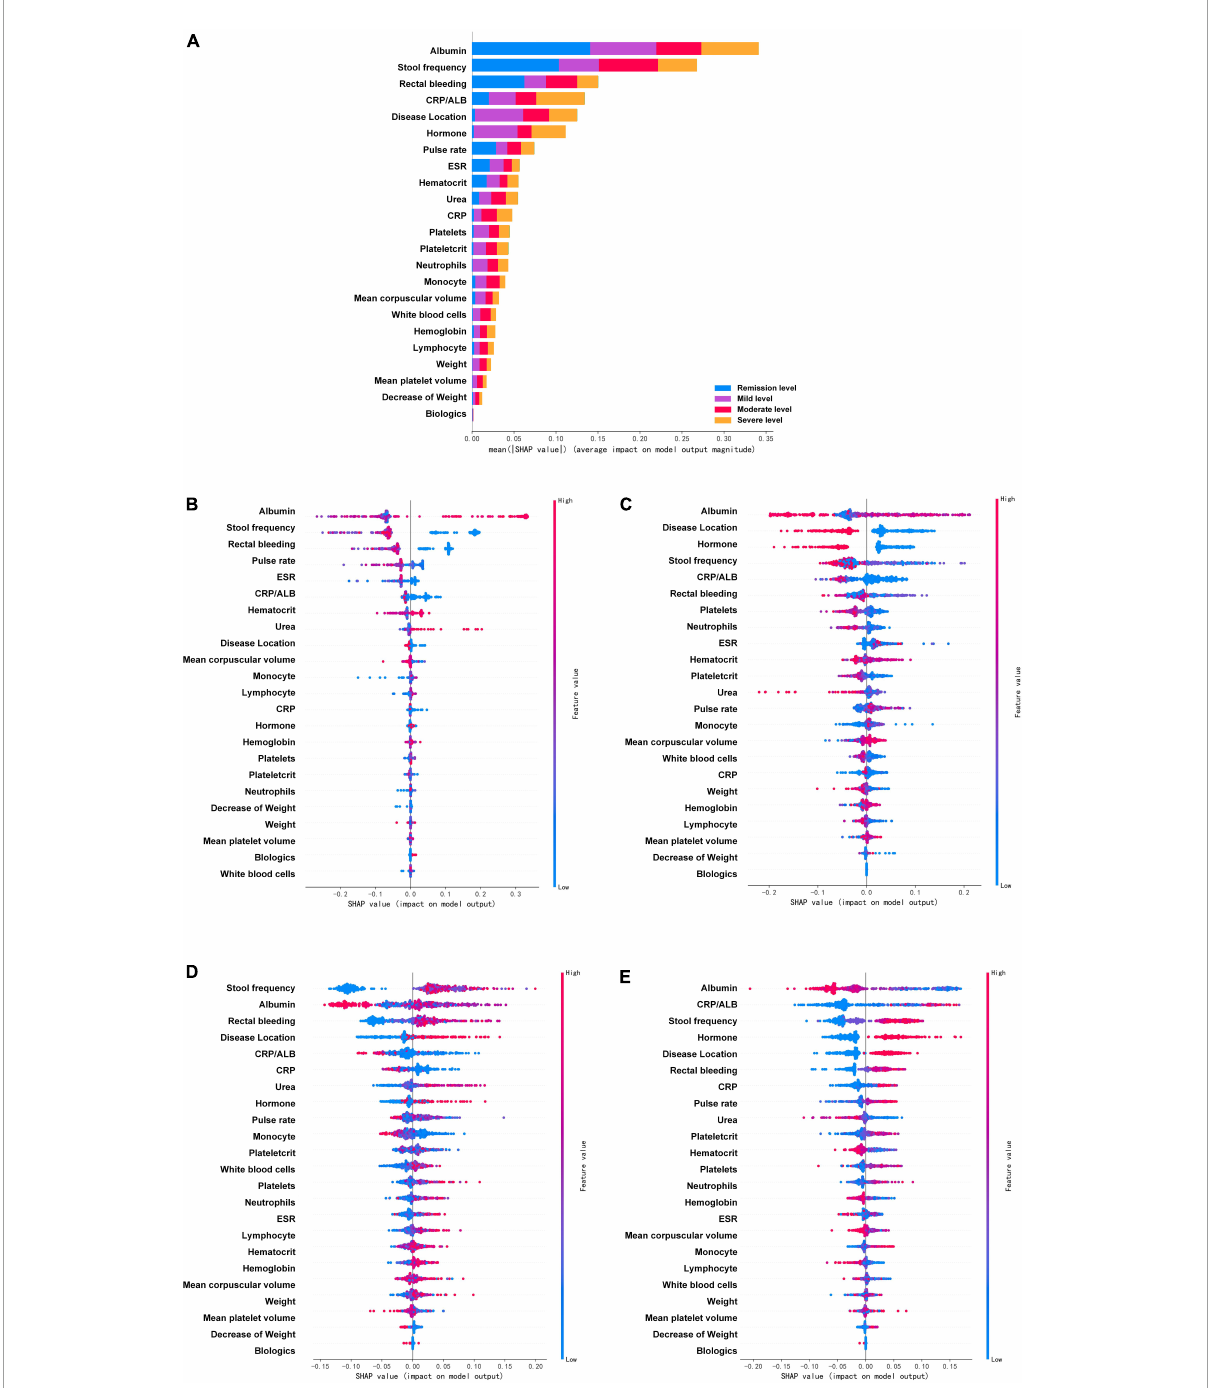
FIGURE4 Feature importance ranking based on Shapley additive explanations (SHAP) values in mayo endoscopic subscore based RF model. (A) The contribution of each variable to the overall model. The different colors represent the contribution given by the variable under that classification. (B–E) Analysis of all variables’ SHAP values at each classification level, each point in the figure represents a sample. The variables are ranked according to the sum of the SHAP values for all patients in the remission level (B) , mild level (C) , moderate level (D) , and severe level (E) . Red indicates that the value of a variable is high, and blue indicates that the value of a variable is low. The x-axis indicates the effect of SHAP values on the model output. The larger the value of the x-axis, the greater the probability of this level. ESR, erythrocyte sedimentation rate; CRP, C-reactive protein; ALB,